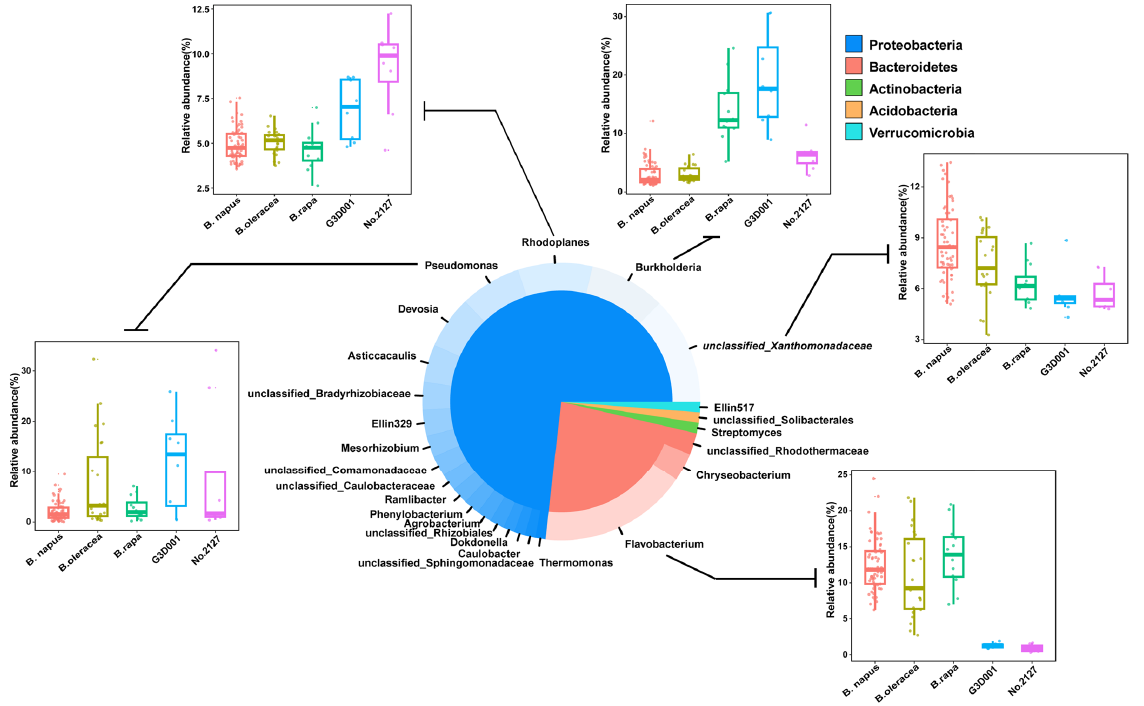
Figure 4. Rhizosphere core microbiota of B. napus and its relatives B. oleracea and B. rapa. Different portions within the inner pie chart represent the bacterial phyla that are part of the B. napus, B. oleracea, and B. rapa core microbiota. The outer donut plot represents the genera that are part of the core, and each genus is assigned to the phylum to which it belongs. Different sizes of the pie and donut portions represent the contribution of each phylum/genus to the total relative abundance. Box plots depict the relative abundance of selected genera.